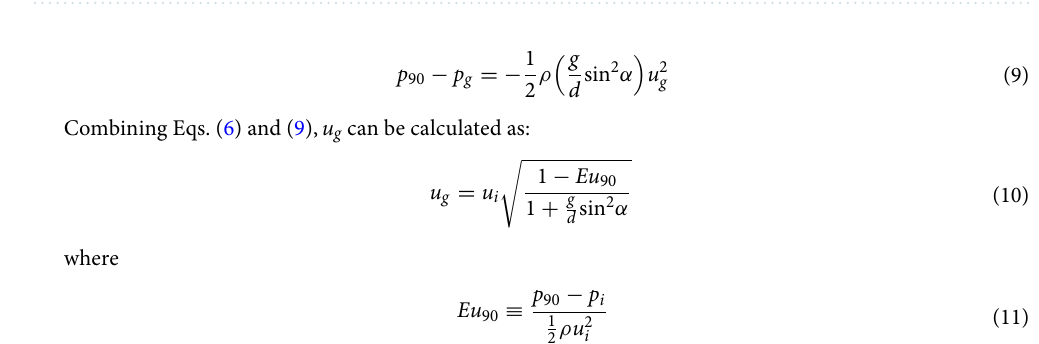
Figure 8. Diagram of the characteristic cross sections, frontal (left) and from above (below). Created with Microsoft Word